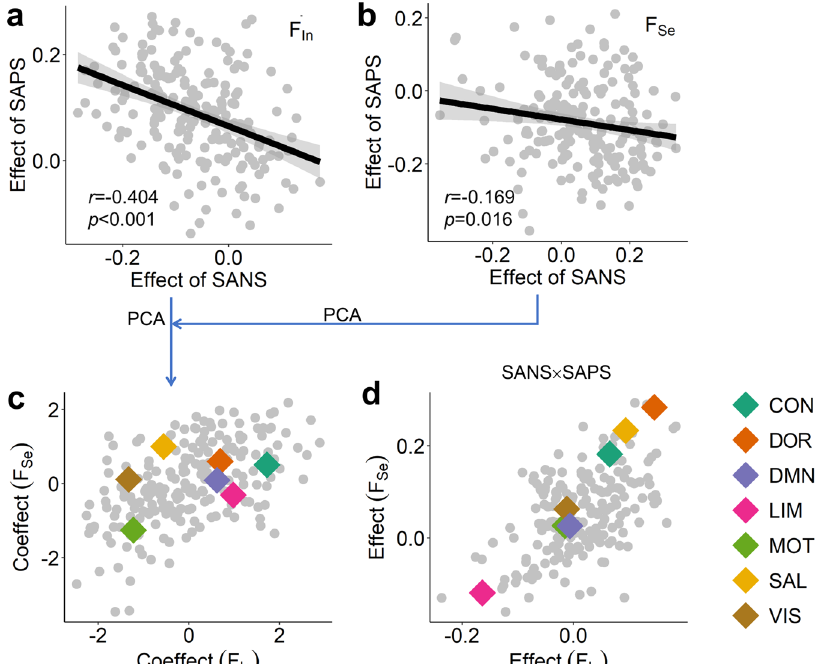
Fig. 4 Effects of schizophrenia symptoms on brain networks. Effects of SANS/SAPS on a dynamic integration variability F In and b segregation variability F fi cients in the multiple regression model (Eq. 8). c Coeffects of SANS/SAPS on integration variability Se . The effects were measured by the regression coef F F In and segregation variability Se . The coeffects were obtained from a and b using principal component analysis (PCA). The averaged coeffects of SANS and SAPS on regions within seven functional systems are marked . d Interaction effect of SANS and SAPS on integration variability F In and segregation variability F Se . The coeffects on the seven functional systems are also shown (see similar results for the brain parcellation of 500 regions in Supplementary Fig.